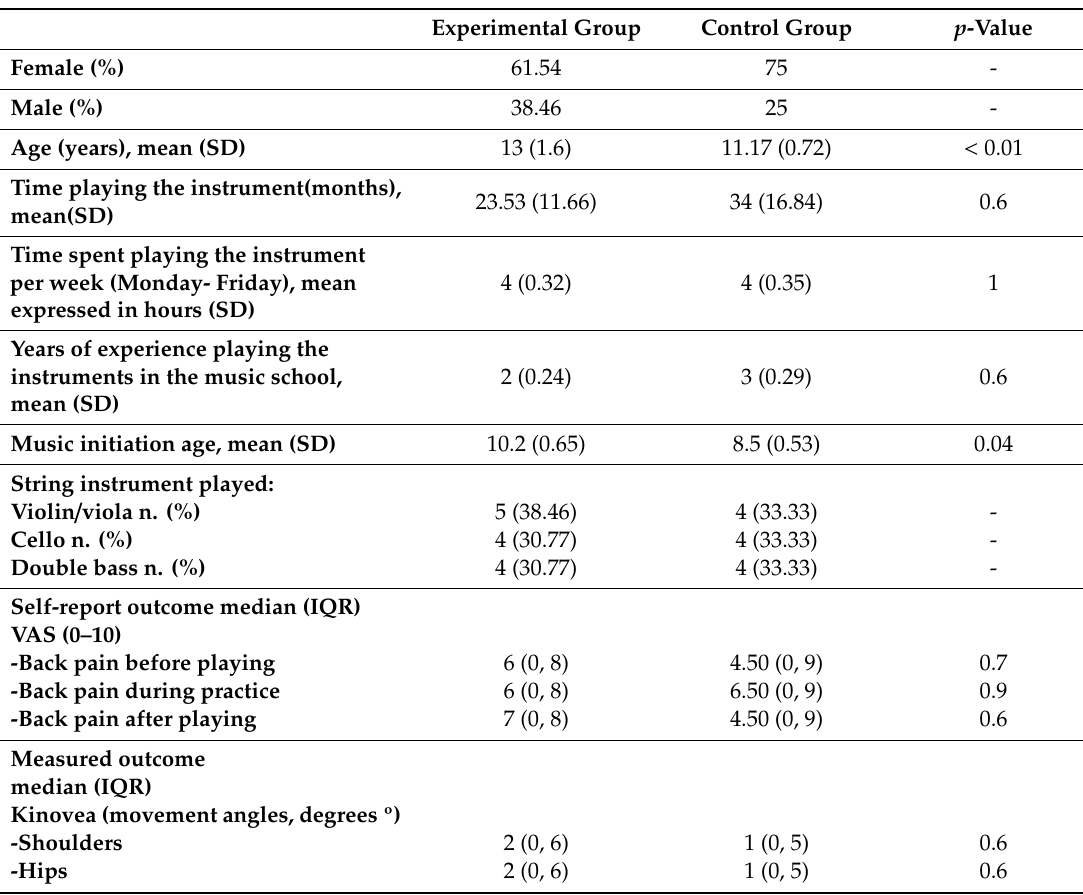
Table 2. Baseline characteristics of the participants in the experimental and control